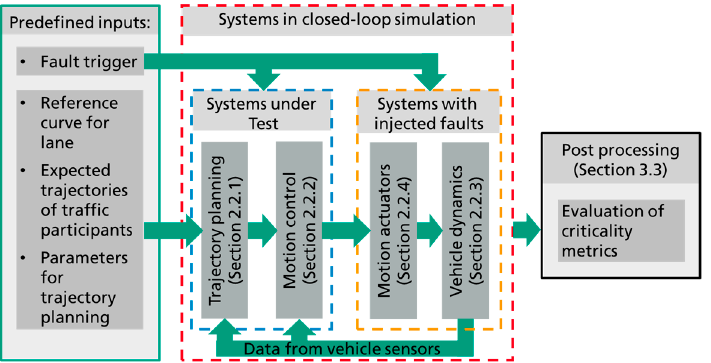
Figure 2. System boundaries for numerical fault injection tests related to vehicle dynamics and ac- tuators.